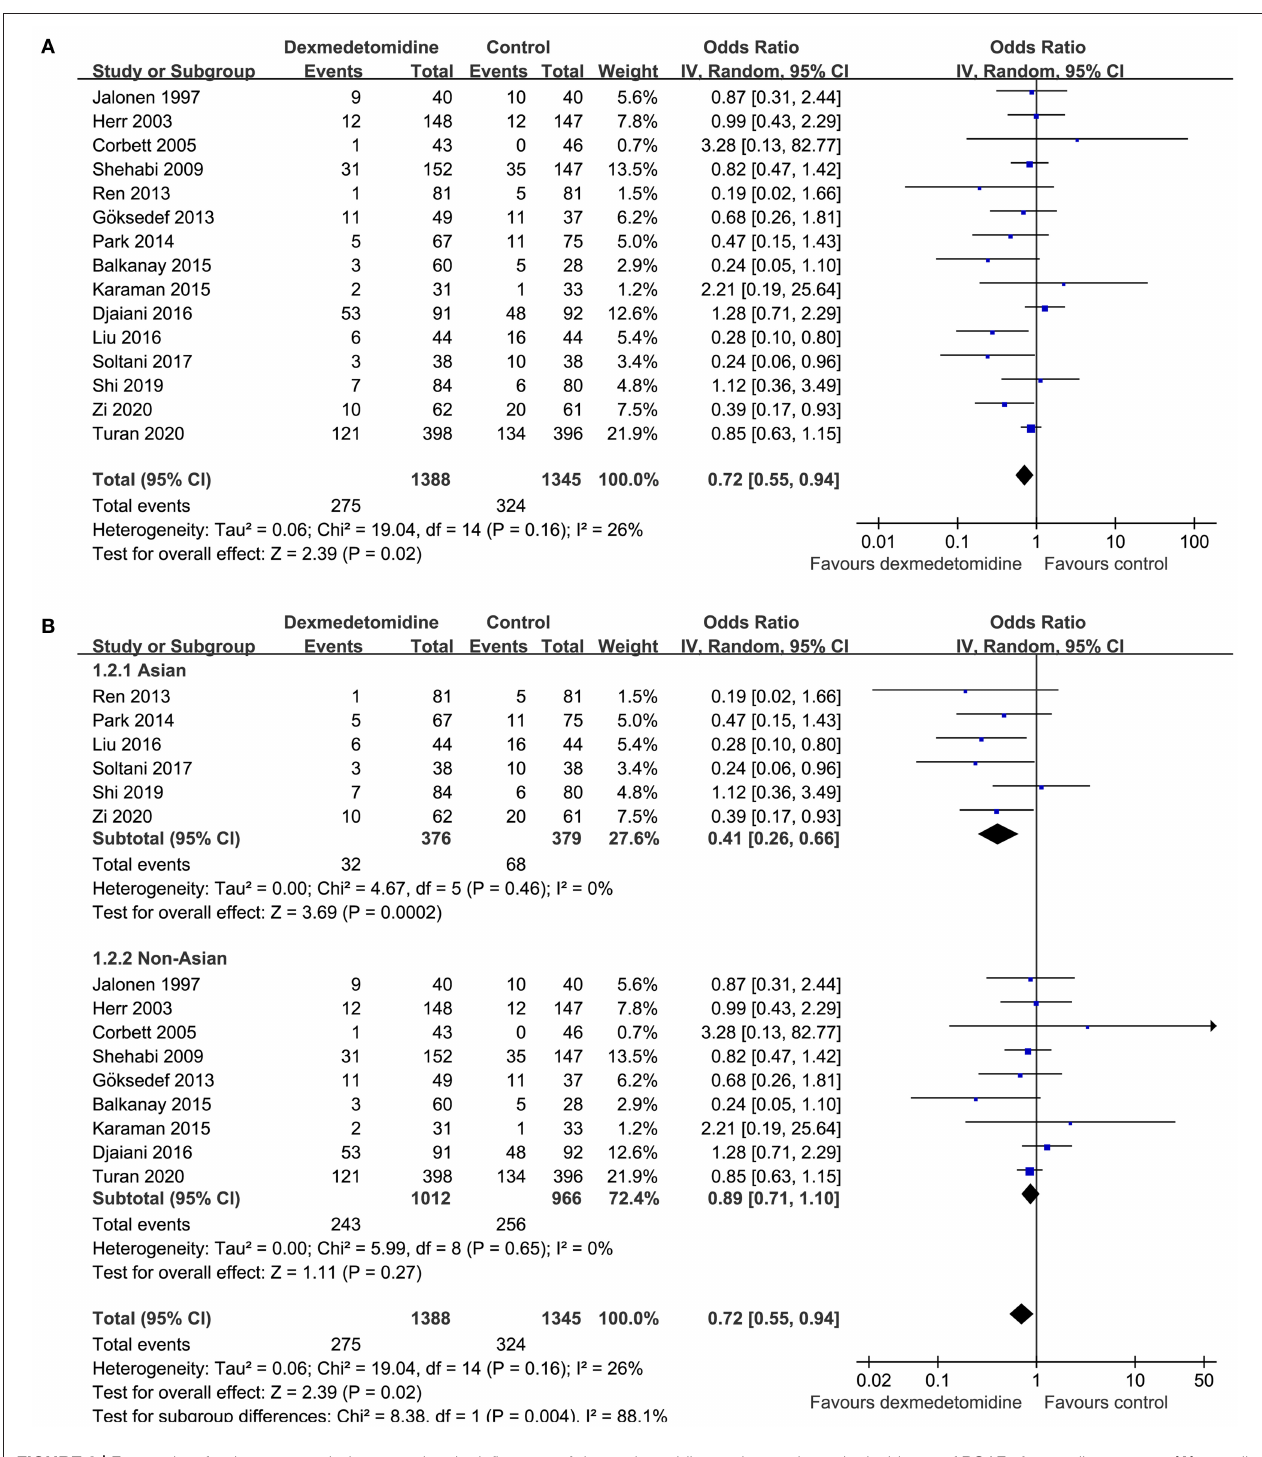
of the vagus nerve (36). A subsequent retrospective case series supported that Dex may have novel antiarrhythmic properties for the acute termination of reentrant supraventricular